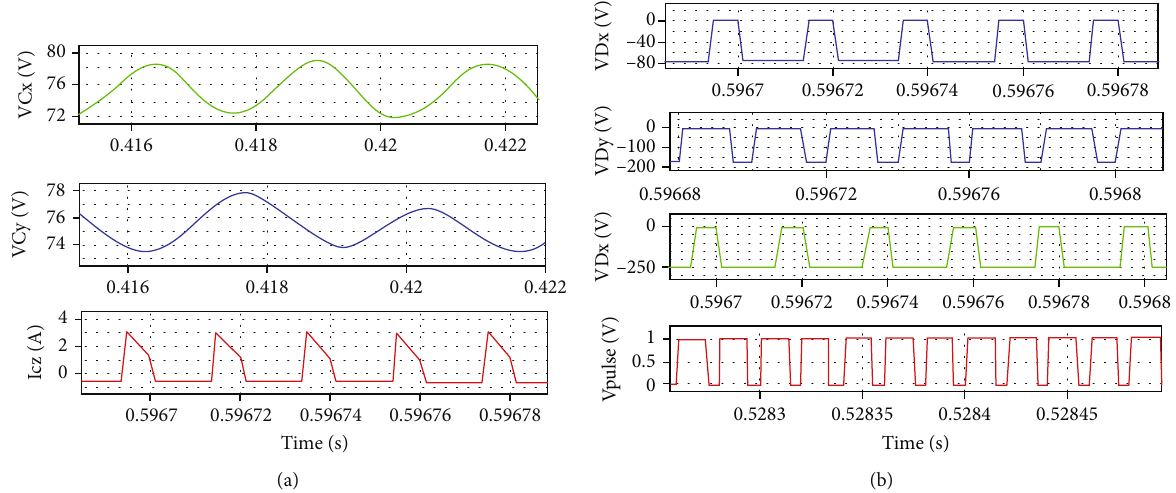
V Cx , Cy , and current